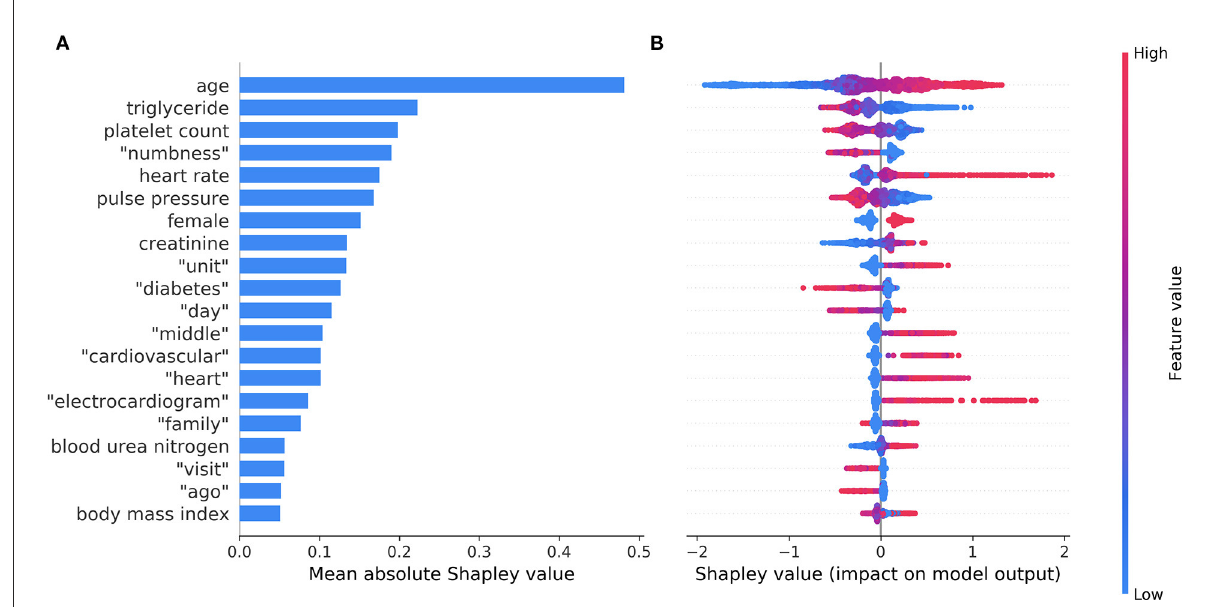
FIGURE4 The top 20 most important features identified by the model based on both structured data and unstructured textual data. The mean absolute Shapley values that indicate the average impact on model output are shown in a bar chart (A) . The individual Shapley values for these features for each patient are depicted in a beeswarm plot (B) , where a dot’s position on the x-axis denotes each feature’s contribution to the model prediction for that patient. The color of the dot specifies the relative value of the corresponding